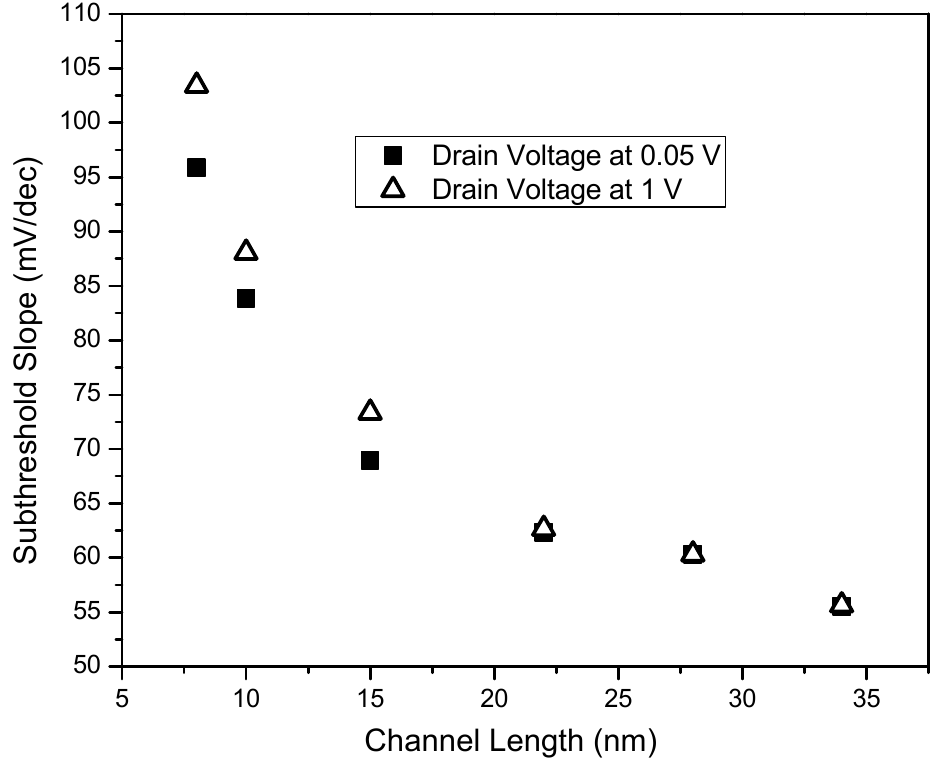
Figure 6. Subthreshold swing (in mV/dec) vs. channel length (in nm) at V D = 0.05 V (in a square) and V D = 1 V (in a triangle). This increase in SS as channel length decreases is the result of the increased contribution of drain voltage and increased depletion at the contacts.